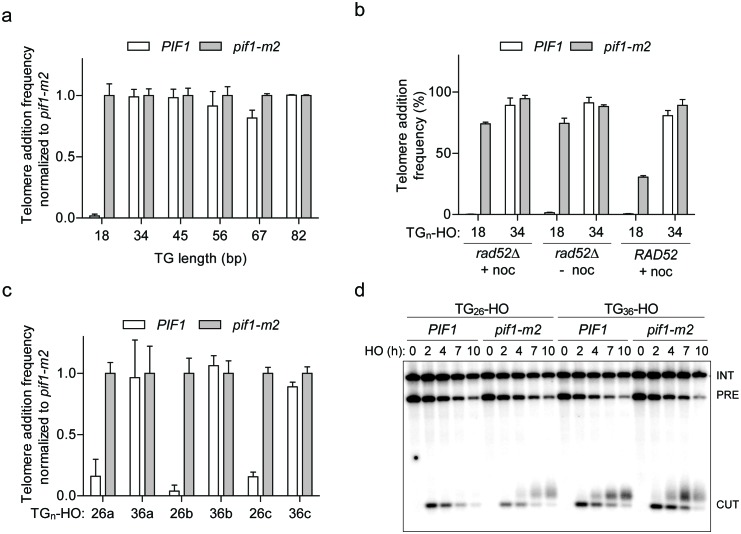
Characterizing a threshold of Pif1 activity at DNA ends.(a) Telomere addition frequency normalized to pif1-m2 cells at DNA ends containing 18–82 bp of (TG1-3)n sequence. Data represent the mean ± s.d. from n = 3 independent experiments. Source data are found in Figure 1—figure supplement 1—source data 1. (b) Telomere addition frequency in rad52Δ cells synchronized with 15 µg/mL nocodazole for 2 hr (+noc), asynchronously growing cells (- noc), and in cells harboring a pRS415-RAD52 plasmid. Data represent the mean ± s.d. from n = 3 independent experiments. Source data are found in Figure 1—figure supplement 1—source data 2. (c) Telomere addition frequency normalized to pif1-m2 cells at DNA ends containing 26 bp or 36 bp versions of three different natural telomeric (TG1-3)n sequences. Data represent the mean ± s.d. from n = 3 independent experiments. Source data are found in Figure 1—figure supplement 1—source data 3. (d) Southern blot of DNA ends containing the TG26b and TG36b ends in wild-type (WT) and pif1-m2 cells following HO induction. A URA3 probe was used to label the ura3-52 internal control (INT) and the URA3 gene adjacent to the TGn-HO insert (PRE) which is cleaved by HO endonuclease (CUT).10.7554/eLife.23783.007Figure 1—figure supplement 1—source data 1.Raw data telomere addition assays shown in Figure 1—figure supplement 1a.10.7554/eLife.23783.008Figure 1—figure supplement 1—source data 2.Raw data for telomere addition assays shown in Figure 1—figure supplement 1b.10.7554/eLife.23783.009Figure 1—figure supplement 1—source data 3.Raw data for telomere addition assays shown in Figure 1—figure supplement 1c.